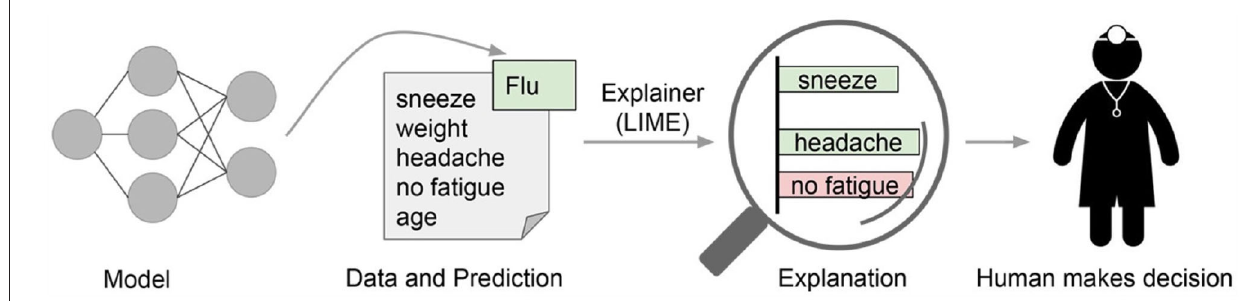
FIGURE 5 | LIME: Explaining individual predictions in the medical context (Ribeiro et al.,